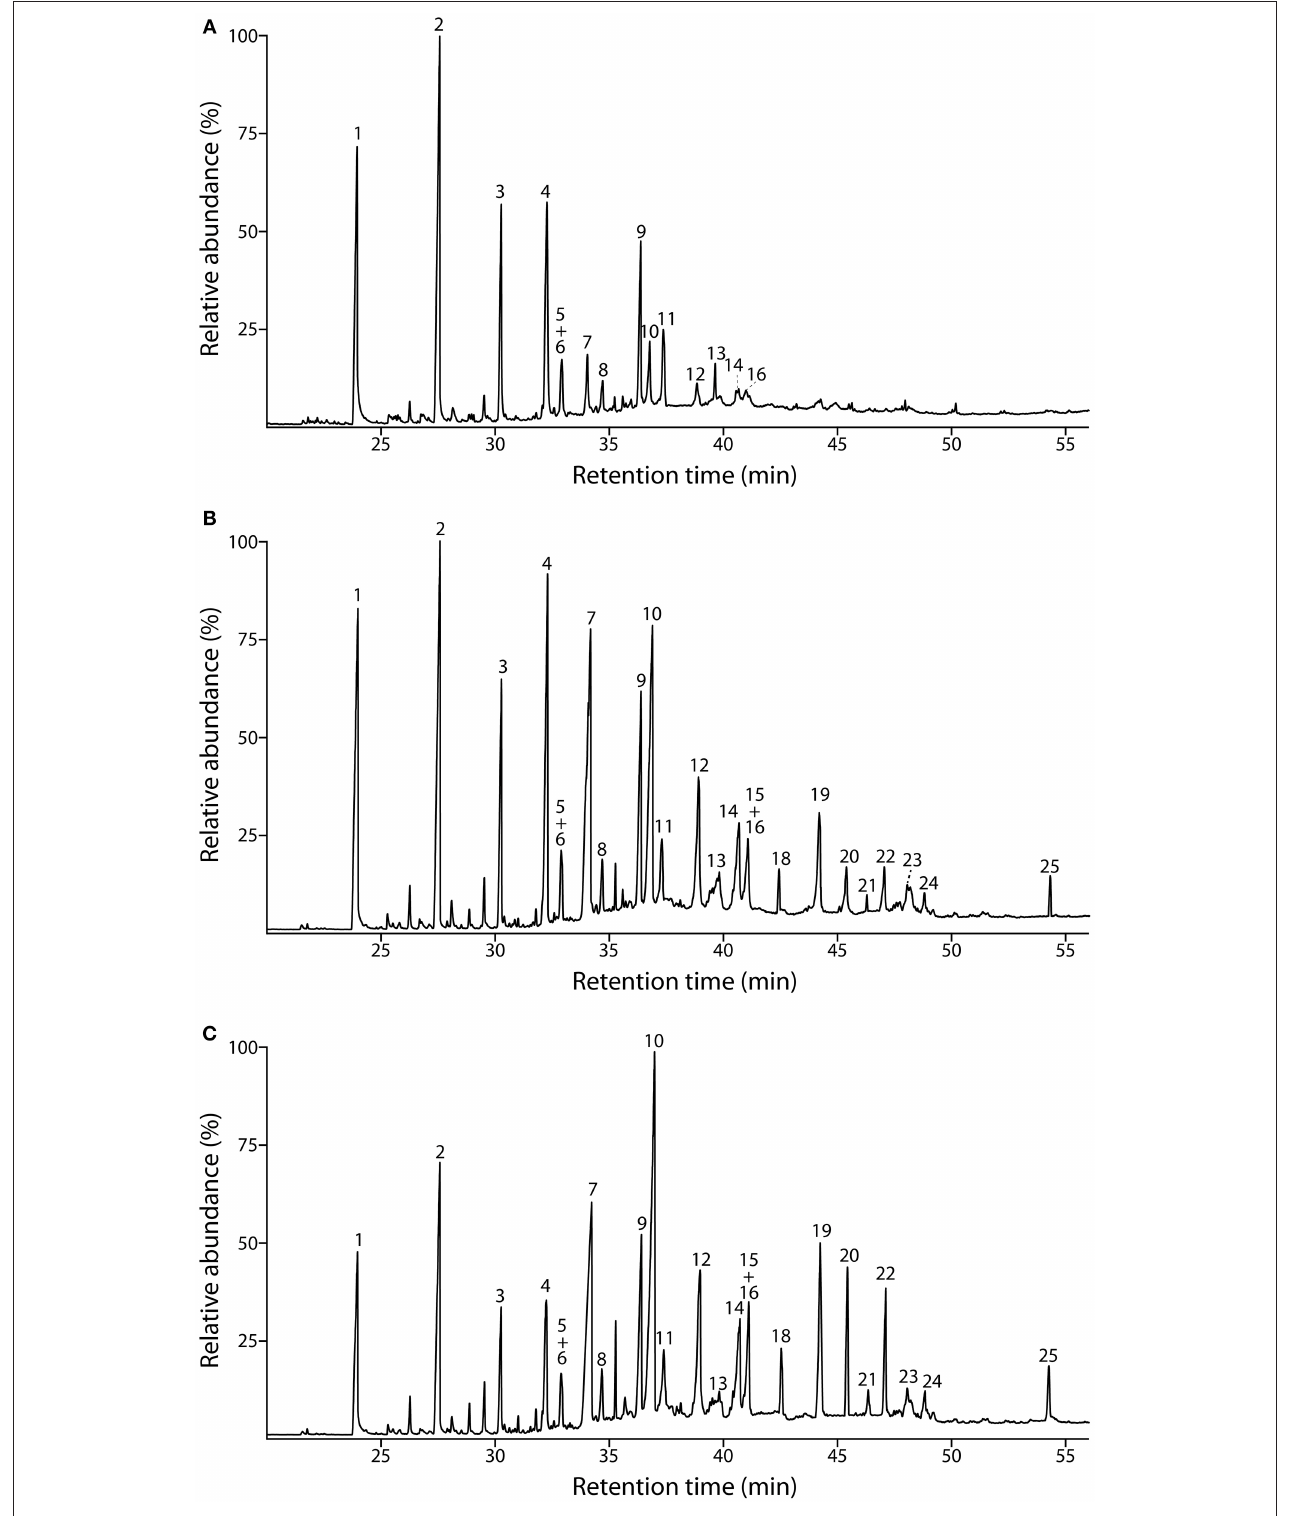
FIGURE 2 | Py-GC/MS chromatograms of the milled lignin preparations isolated from the different parts of Q. suber (A) cork, (B) phloem, and (C) xylem. The identities and relative abundances of the released lignin-derived compounds are listed in Table 2 .